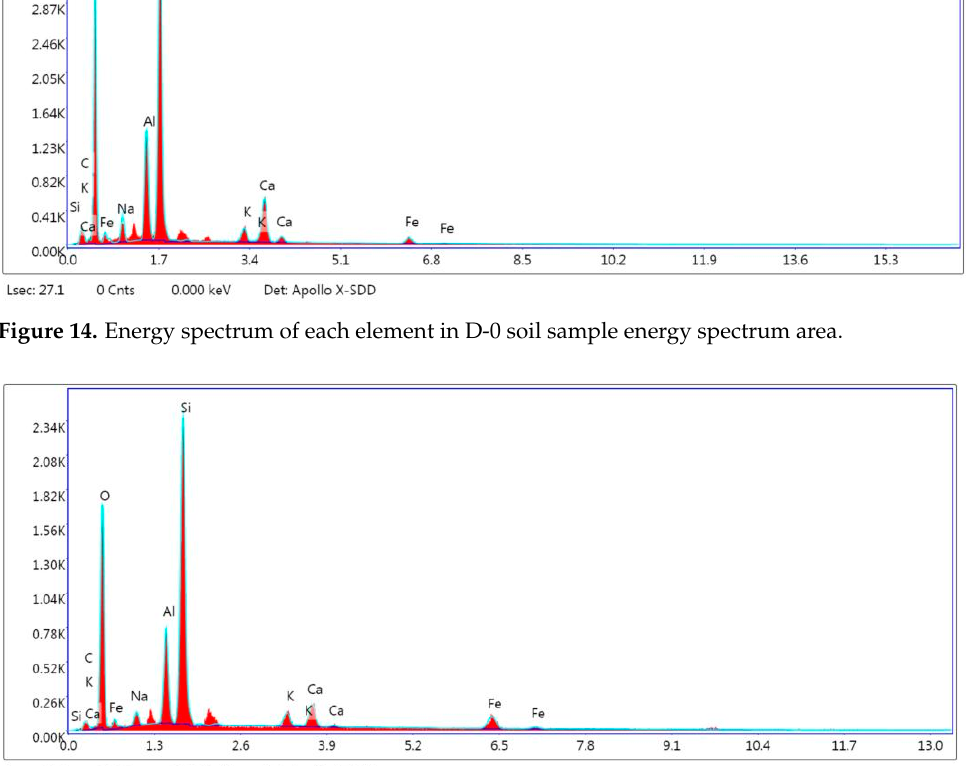
Figure 14. Energy spectrum of each element in D-0 soil sample energy spectrum area.